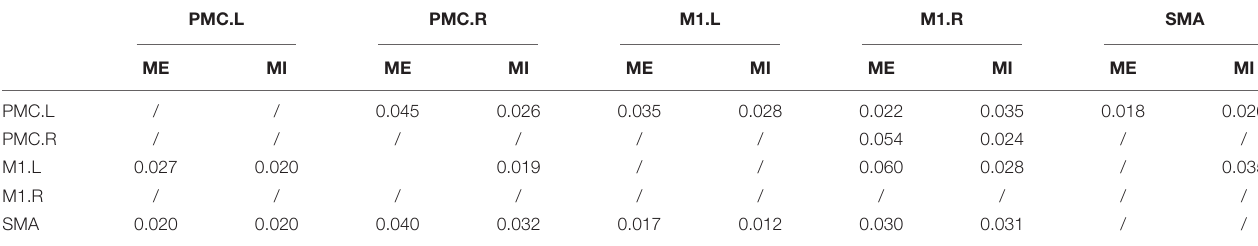
TABLE 3 | The value of conditional Granger causality in the young group during ME and MI. PMC.L PMC.R M1.L M1.R SMA ME MI ME MI ME MI ME MI ME MI PMC.L / PMC.R